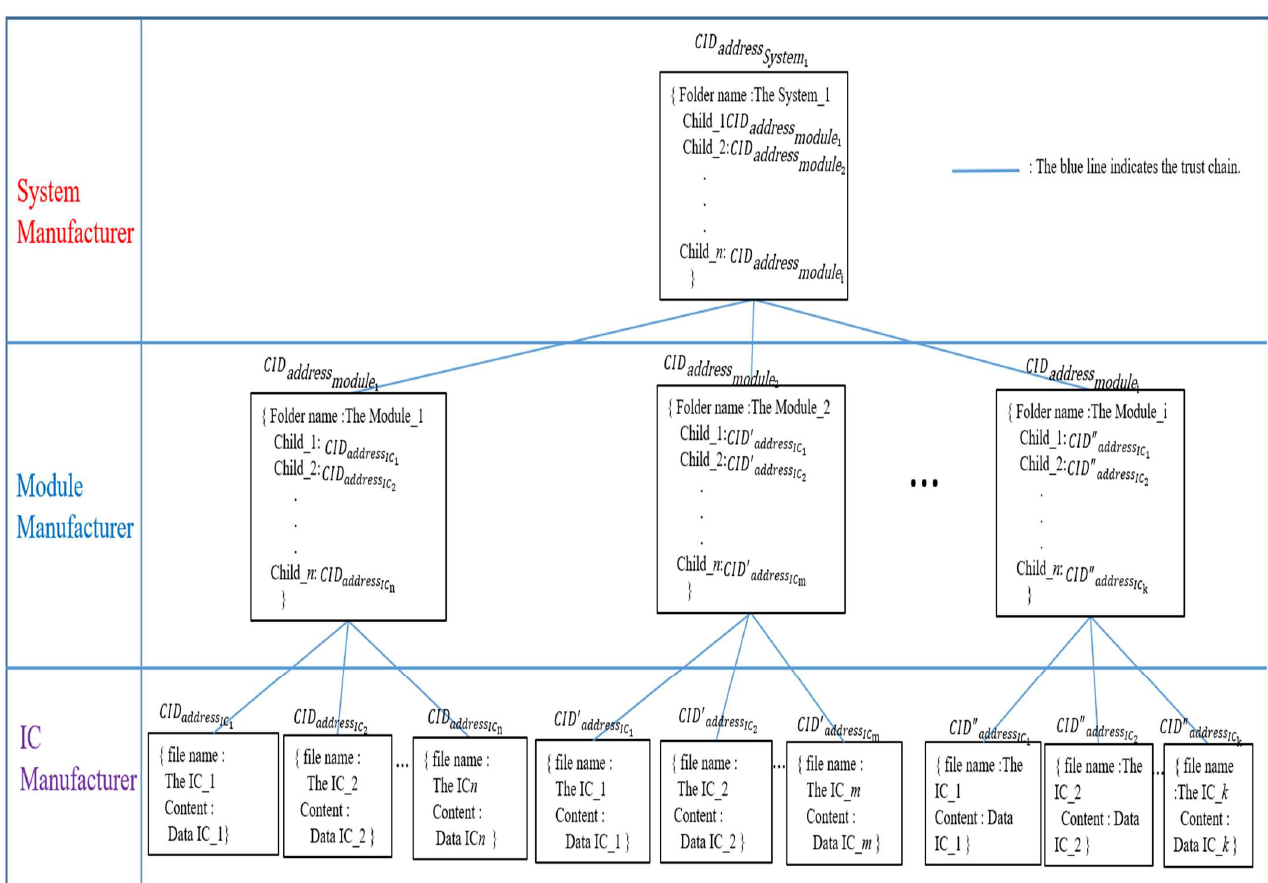
Figure 11. Merkle DAG in HCIDM performed in web-based DApp is activated and organized the trust chain in our framework on when any version data of IC, module or system is recorded.